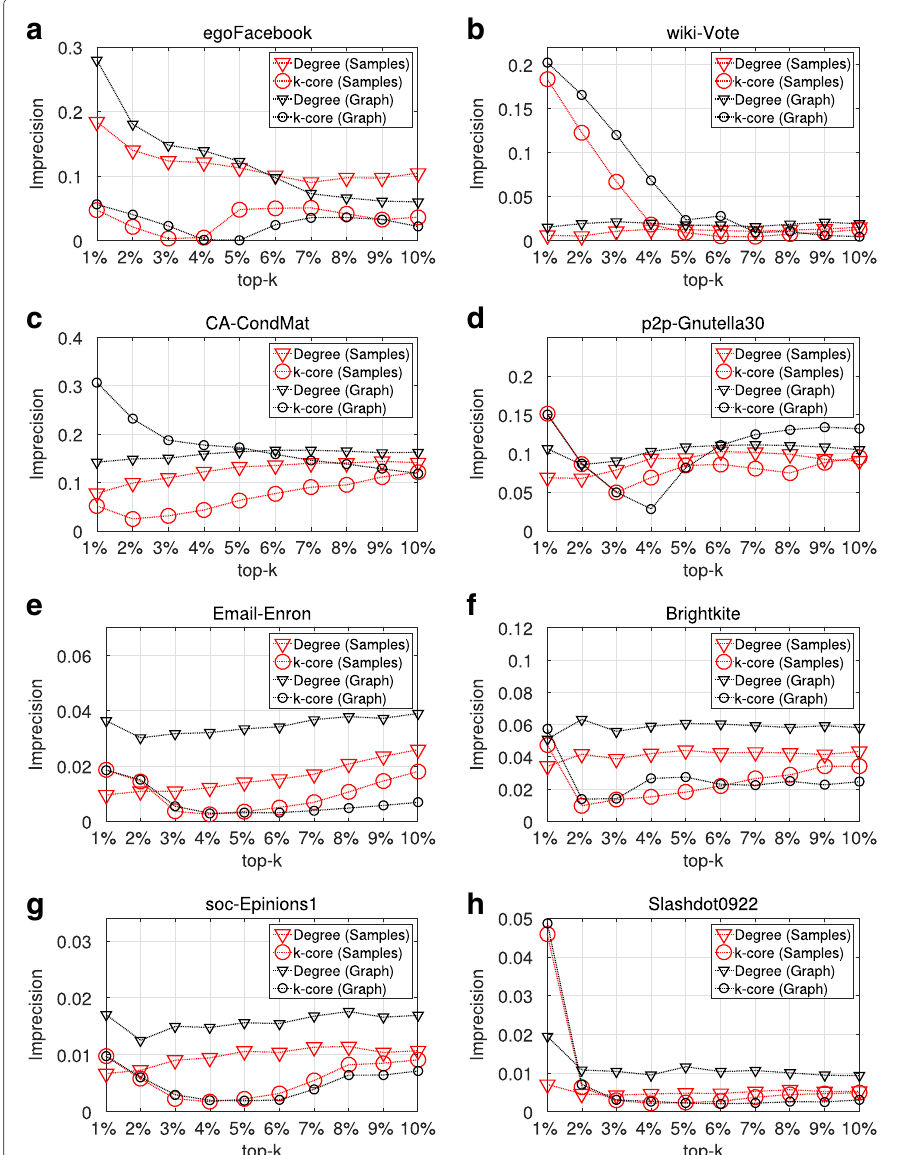
Fig. 1 Top-k spreading efficiency, SIR epidemic. a - h Imprecision values in terms of degree centrality and k-core obtained from maxRD samples, as well as from the original